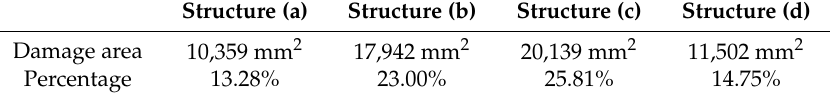
Table 3. Parameters of ultrasonic C-scanning.